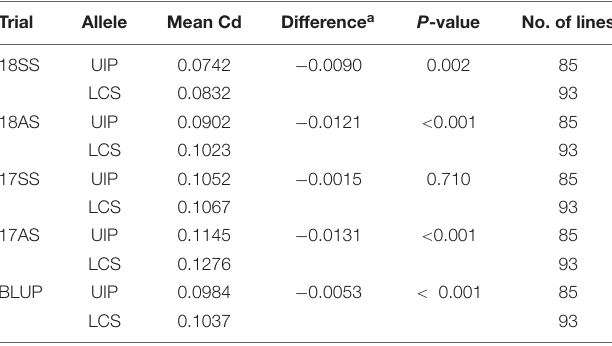
TABLE 7 | Allelic effect of TaHMA2 on grain Cd content in UI Platinum × LCS Star-derived population. Trial No. of lines